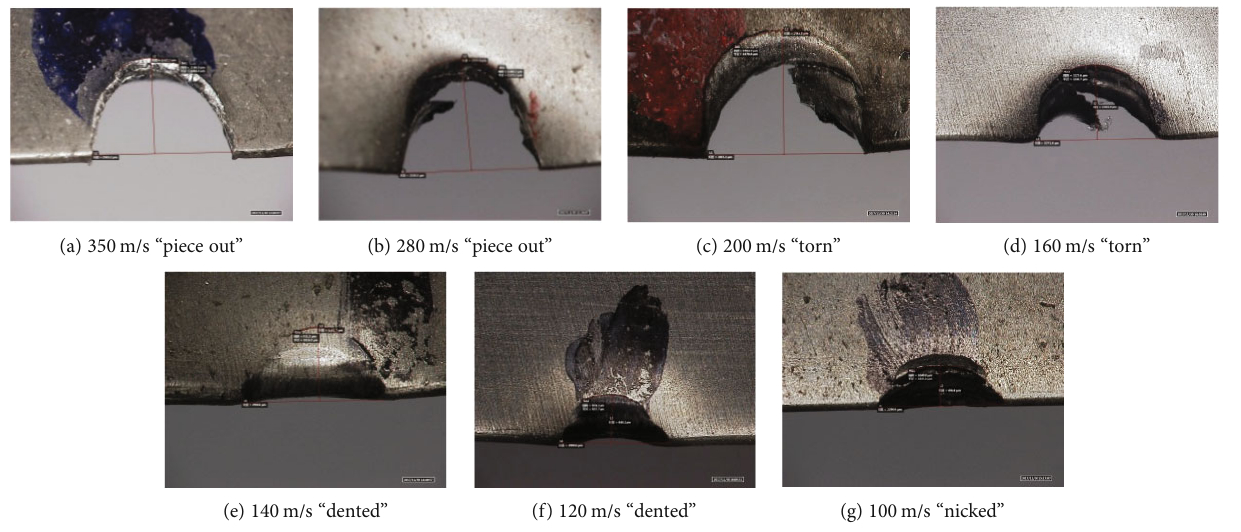
Figure 9: The typical damage of blade under 30 °